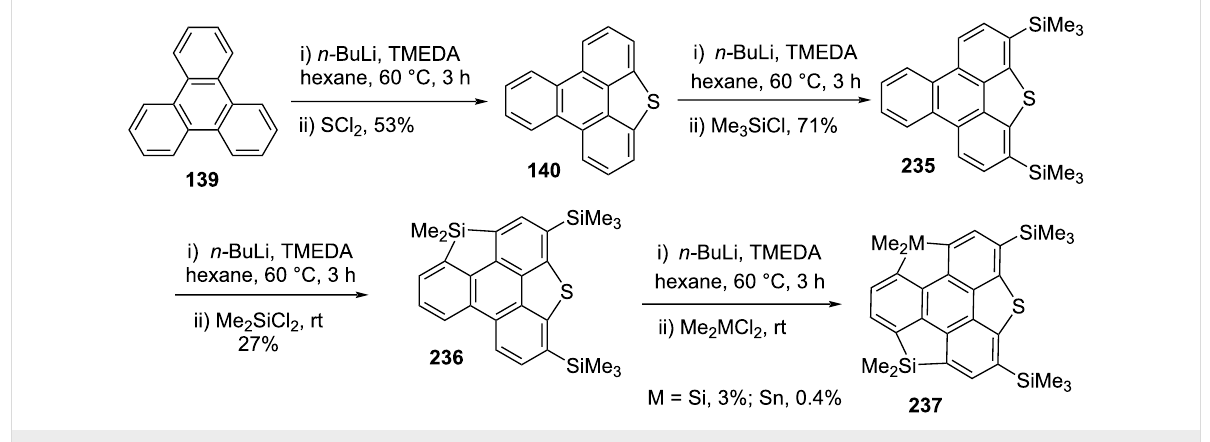
Scheme 57: Synthesis of heterasumanene containing three different heteroatoms.